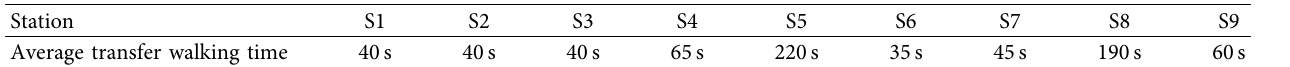
Table 5: Average transfer walking time.